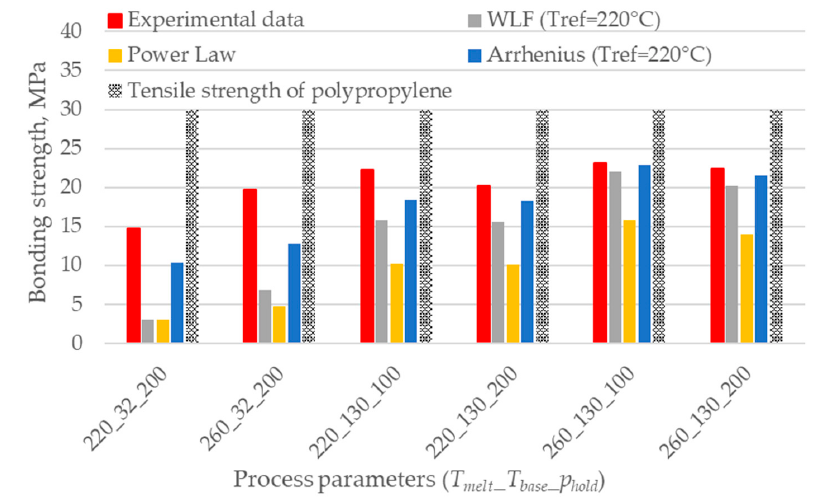
Figure 9. Comparison between the experimental bonding strength and the predictions based on the first 0.09 s of the interface temperature evolution. The combination of process parameters is expressed using the code T melt _ T base _ p hold .